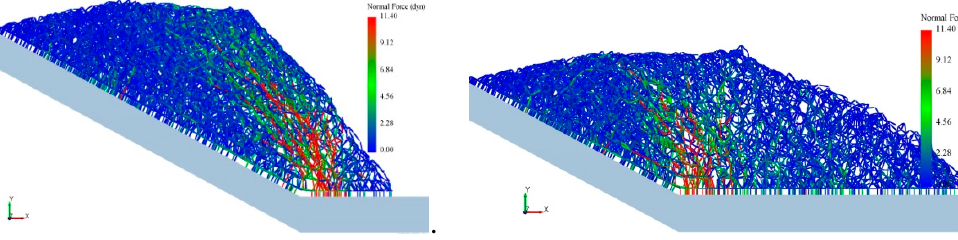
Figure 12. Diagram of normal force of wet soil sliding at the slope foot ( γ = 0.2 J/m 2 , d = 0.7 mm).